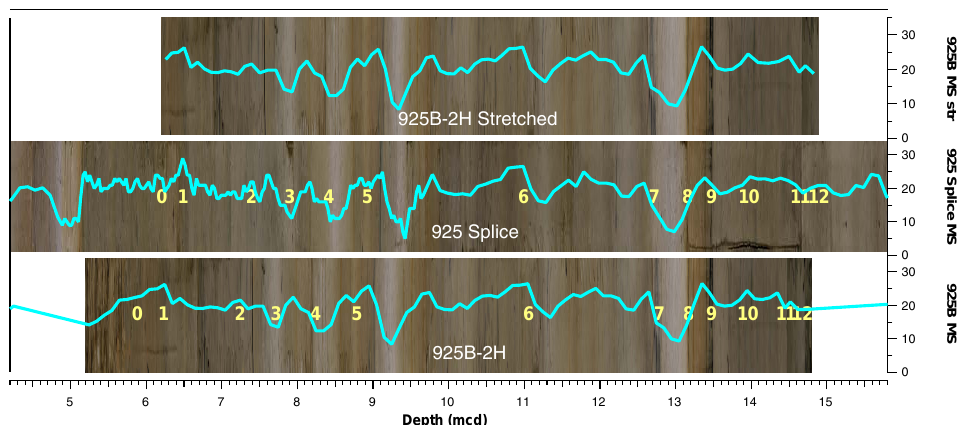
Figure 4. Core 925B-2H was not used for the Site 925 splice, and while there is good alignment between the core image and data and the spliced image and data at 13–14mc.d., shallower portions of the core are not well aligned with the splice. Yellow numbers indicate tie points used to stretch the image and data so that they are in better agreement with the splice. Choice of tie points is cursor driven and stretching can be recalculated in real